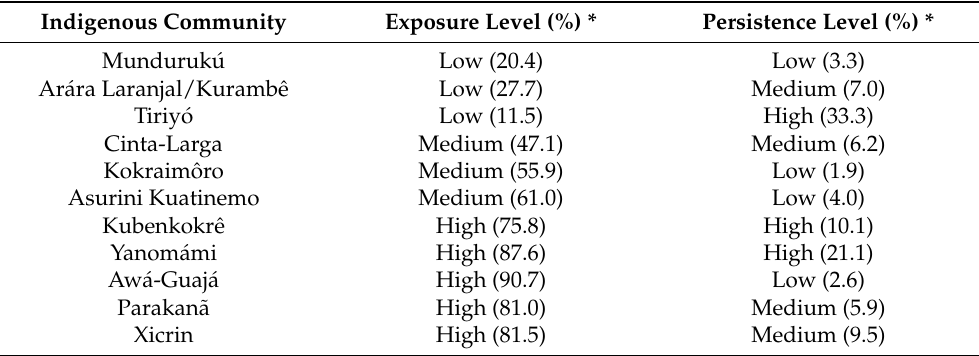
Table 2. Levels of exposure to and persistence of Chlamydia infection among isolated indigenous peoples of the Amazon region of Brazil